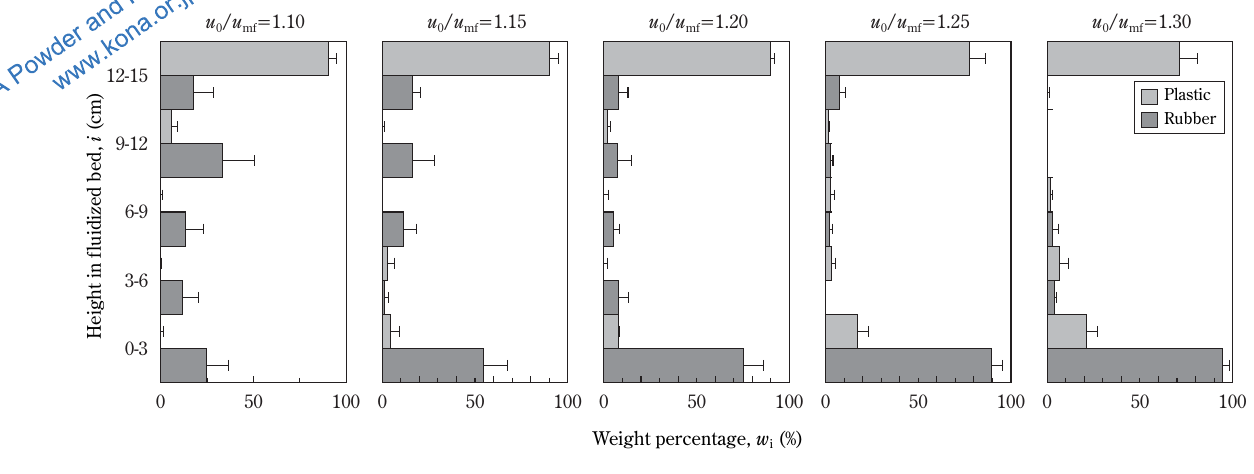
Fig. 14 Weight percentages of plastic and rubber at each height in the fluidized bed at various air velocities